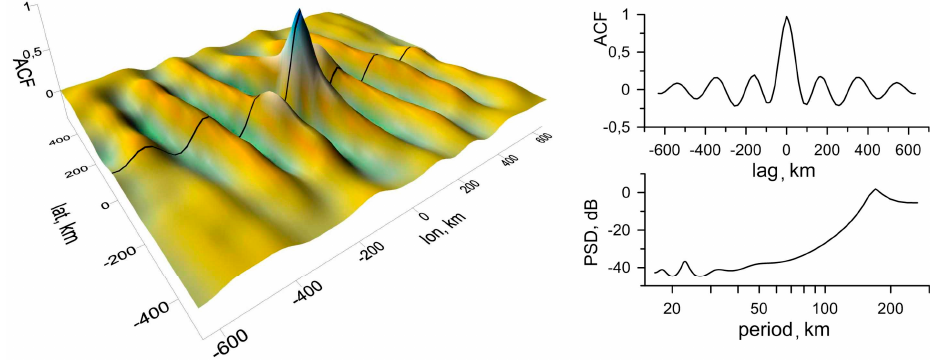
Figure 8. Spatial autocorrelation function (ACF) of TEC variations on 13 March 2013 at 08h50m ( left ), its central profile and periodogram ( right ).